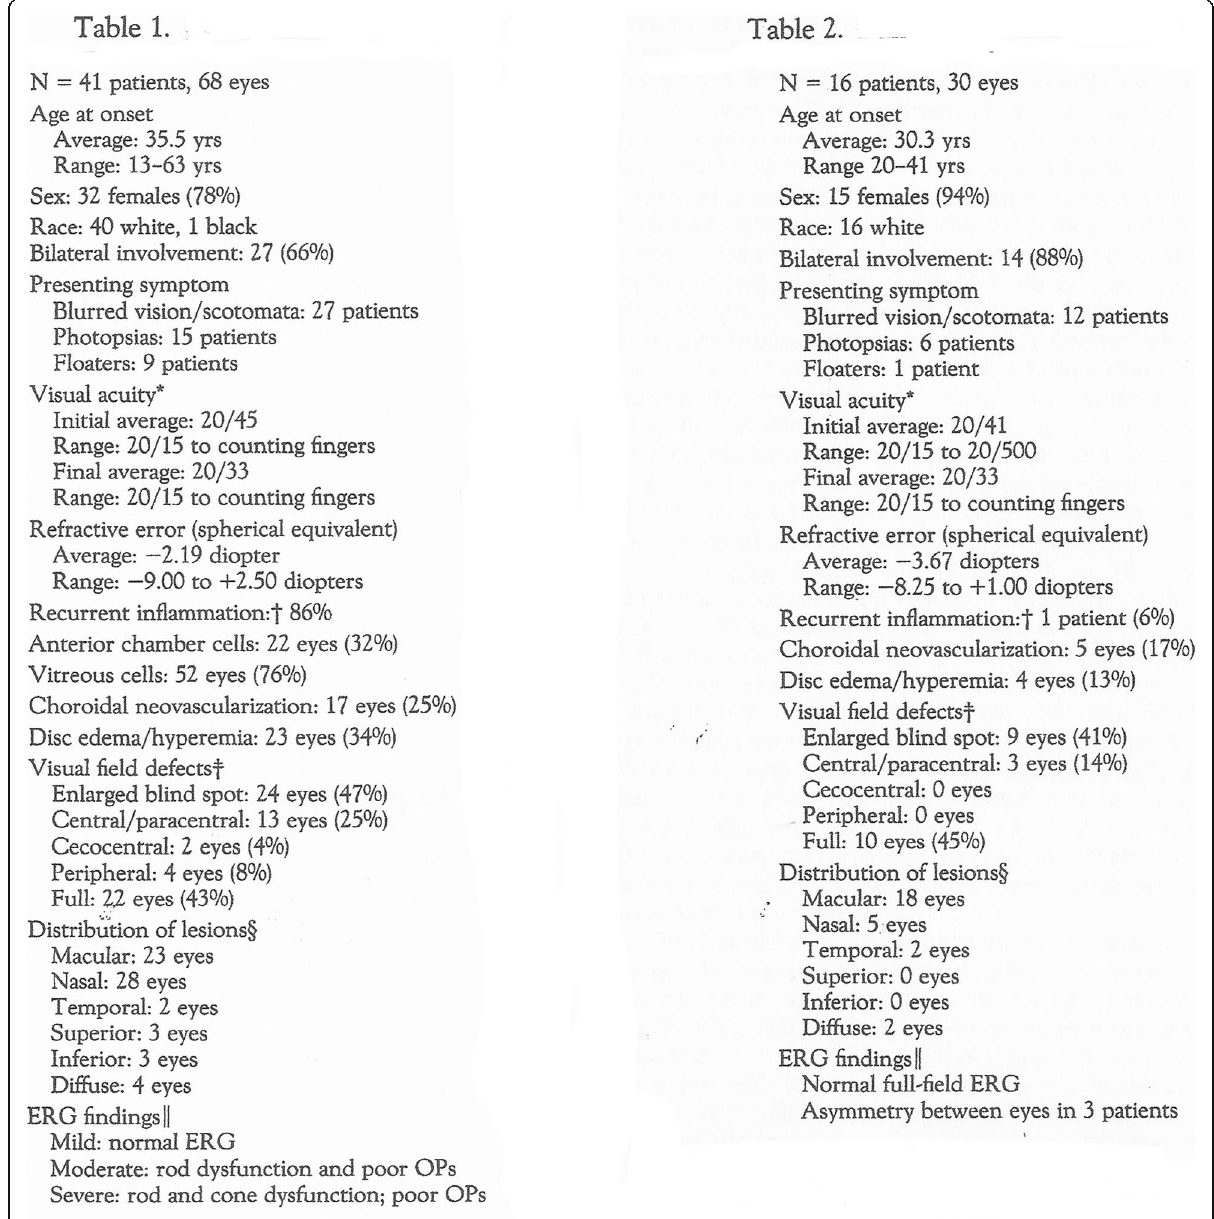
Fig. 1 MFC and PIC are undistinguishable. Two tables defining MFC and PIC for which the titles have been hidden. The two “ entities ” cannot be distinguished and statistical differences among items do not appear to be significant. This is one more argument that the two “ sub-entities ” are one and the same disease